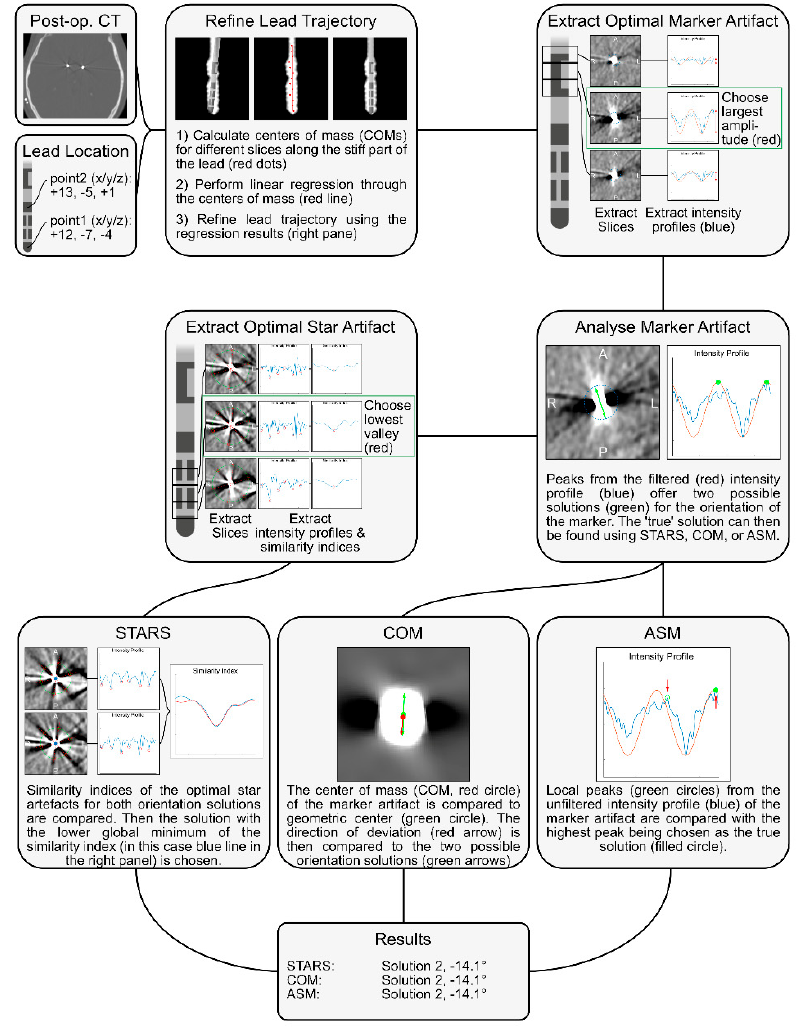
Figure 1. Legend: Flowchart illustrating the different steps of the DiODe v2 algorithm.